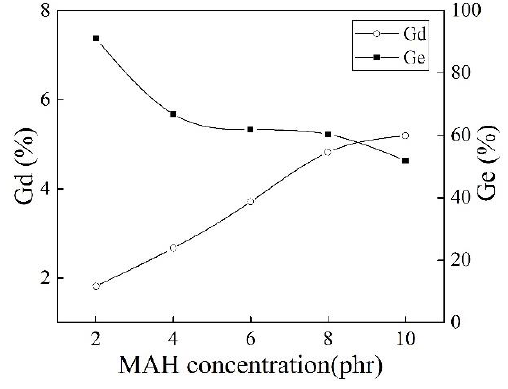
Figure 8. Effect of different MAH concentrations on Gd and Ge of iPB-g-MAH.